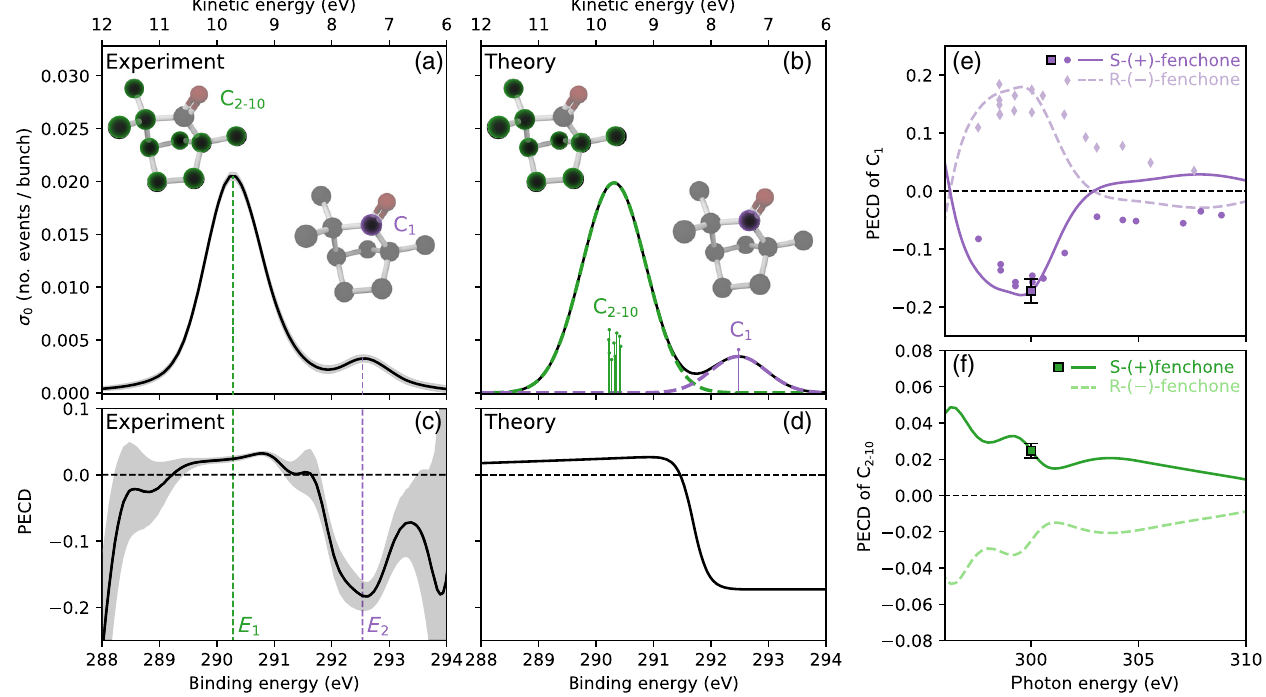
FIG. 2. C K -edge ionization of ground state S-(+)-fenchone. (a) Experimental PES recorded at 300 eV photon energy and (b) a theoretically predicted spectrum based on the calculated C 1 s binding energies. These are marked with green and violet sticks, the lengths of which are intended for clarity only. The gray area in (a) represents the 1 σ confidence interval, multiplied by 10 for clarity. The associated experimental PECD results appear in (c), while in (d) the theoretically predicted PECD for S-(+)-fenchone is presented. The gray area in (c) represents the 1 σ confidence interval. In both (c) and (d), the backward asymmetry from the C 1 localized emission reaches almost 20%. Theoretical PECD asymmetries for S-(+)-fenchone (solid line) and R-( − )-fenchone (dashed line) as a function of photon energy are presented for the C 1 peak in (e) and the unresolved average of the C 2 − 10 peaks is presented in (f). Dots and diamonds in (e) indicate experimental synchrotron data for S-(+)-fenchone and R-( − )-fenchone, respectively (see Ref. [14]). The experimental h ν ¼ 300 eV results from our current work for the C 1 and C 2 − 10 peaks are shown with violet and green square dots in (e) and (f), respectively, along with the corresponding 1 σ error